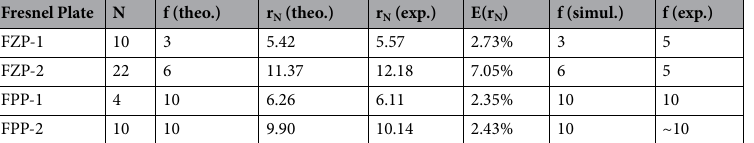
Fresnel Plate N f (theo.) r N (theo.) r N (exp.) E(r N ) f (simul.)